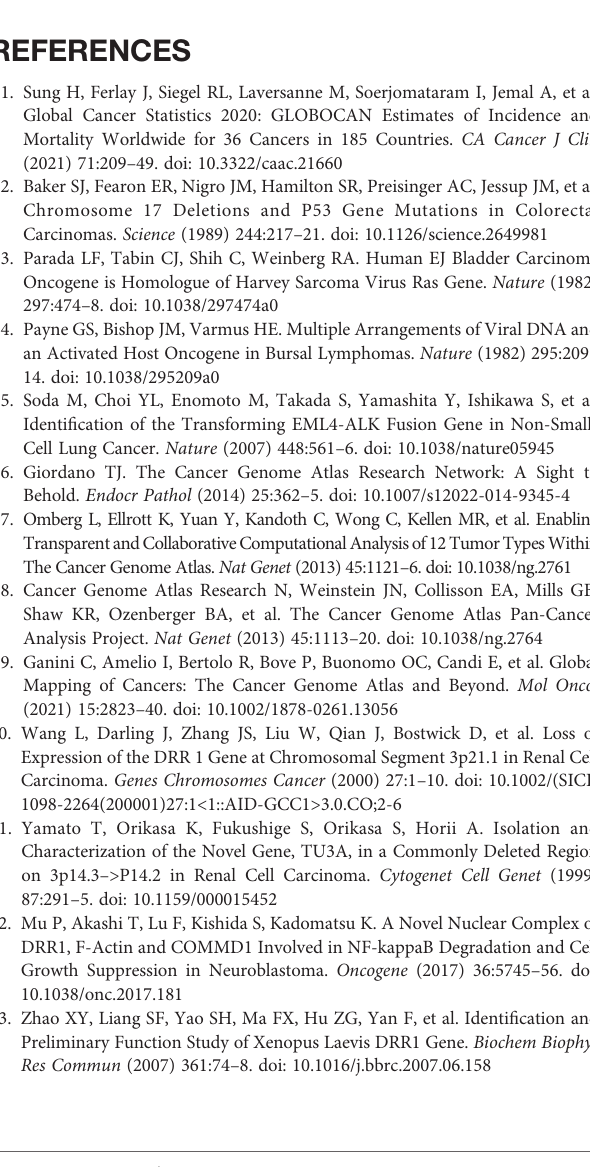
Supplementary Figure 1 | Expression level of FAM107A gene in the tumors in the TCGA project and the corresponding normal tissues of the GTEx database. Supplementary Figure 2 | MRNA expression levels of FAM107A in normal tissues and tumor cell lines. MRNA expression levels of FAM107A in normal tissues in the HPA (Human protein atlas) dataset (A) and GTEx dataset (B) . (C) MRNA expression levels of FAM107A in various tumor cell lines from the Cancer Cell Line Encyclopedia(CCLE) database. Supplementary Figure 3 | ThemutationspectrumofFAM107AacrossTCGApan- cancer studies using cBioPortalOncoprint. Each vertical bar represents a patient. Supplementary Figure 4 | Differential methylation level of FAM107A gene between tumor and corresponding normal tissues in 15 cancer types from DiseaseMeth database.